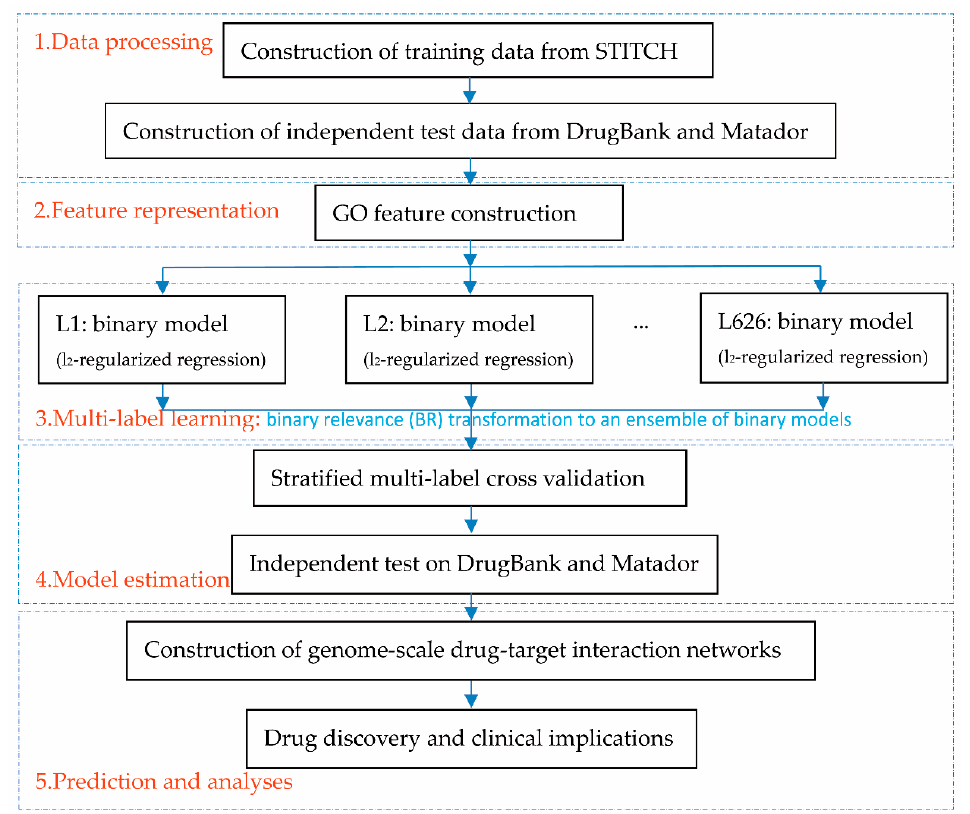
Figure 1. Flowchart overview of multi-label learning framework.